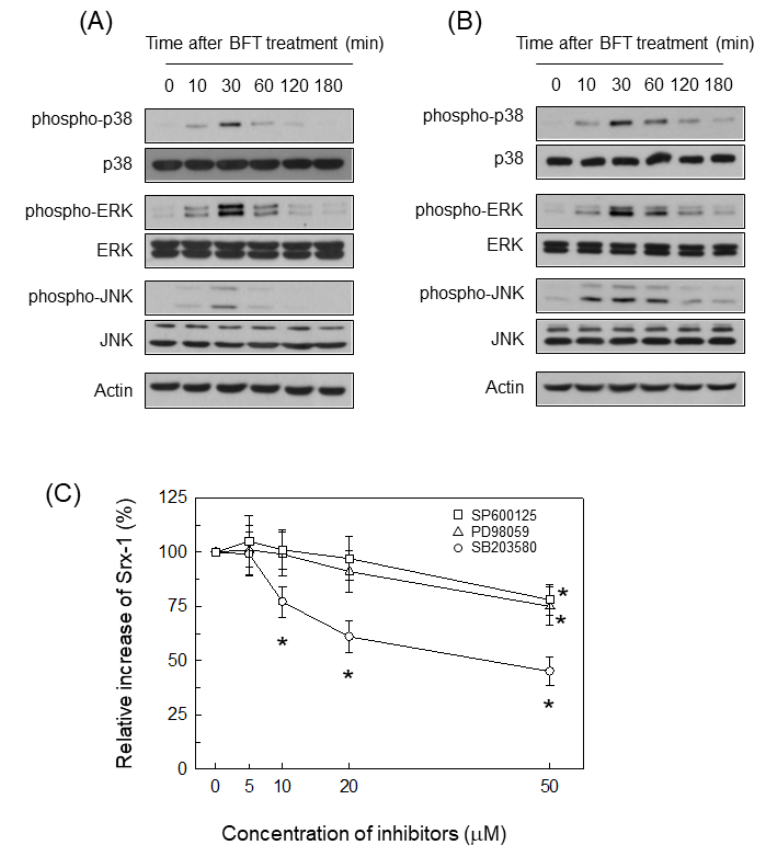
Figure 6. Relationship between chemical inhibition and Srx-1-expression. ( A , B ) BFT (300 ng / mL) was added to CCD 841 CoN cells ( A ) and HCT 116 cells ( B ) for the indicated periods of time. Protein-expression of MAPK signals such as phospho-p38, p38, phospho-ERK1 / 2, ERK1 / 2, phospho-JNK and JNK was examined by western blot. All images in ( A , B ) are representative of more than three independent experiments; ( C ) CCD 841 CoN cells were combined with SP600125, PD98059 or SB203580 for 30 min. BFT (300 ng / mL) was then added to each group for 18 h. Analysis of protein expression of Srx-1 was determined by ELISA. Data were obtained through five independent experiments and expressed as mean% increase relative to unstimulated controls ± SEM. The asterisk indicates that the p -value is less than 0.05 compared to BFT alone.